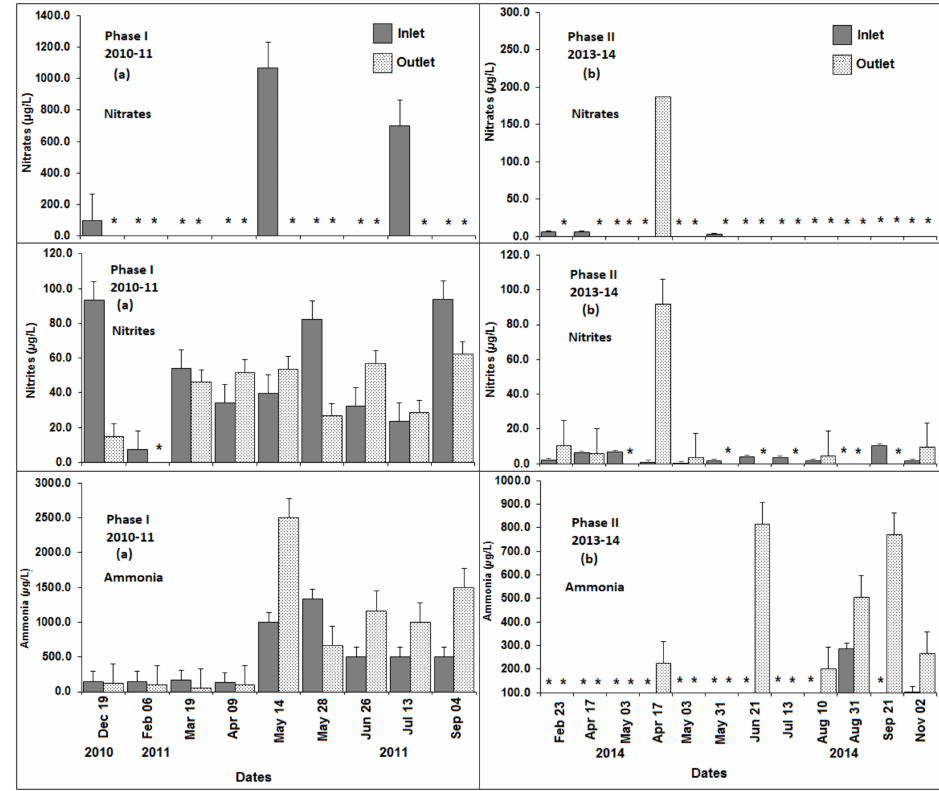
Figure 6. Nitrogen (nitrate, nitrite, and ammonia) from combined inlet and the lagoon’s outlet for the period of: ( a ) 19 December 2010 to 4 September 2011 (Phase One) and ( b ) 23 February 2014 to 2 November 2014 (Phase Two). (*)Values are treated as zero (0) or if the measurable absorbance is less than the calibration range of the test.